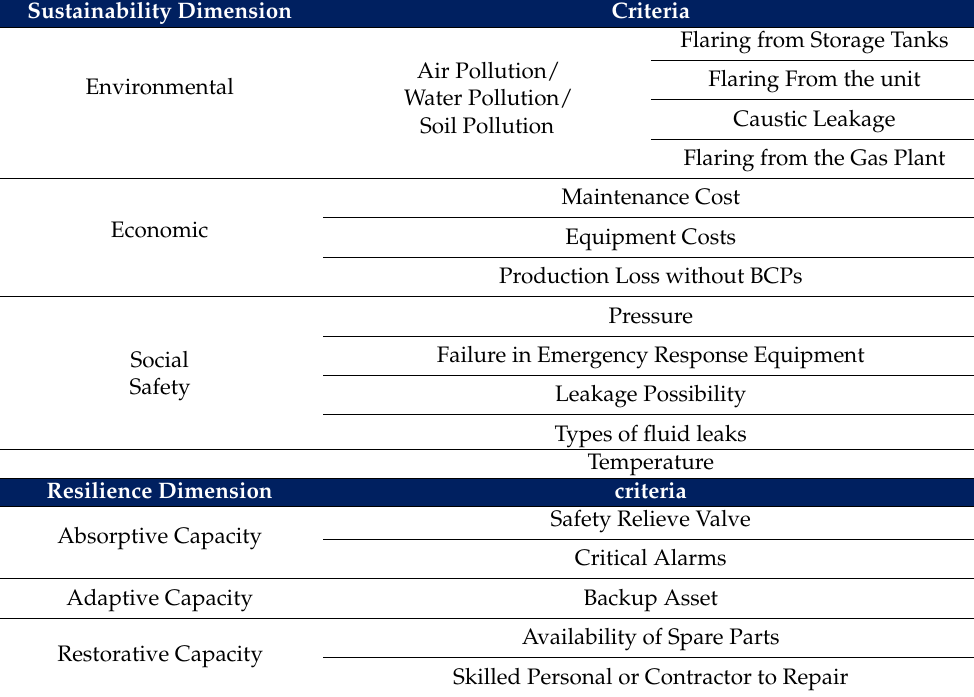
Table 3. Sustainability and resilience factors for GP’s physical asset criticality